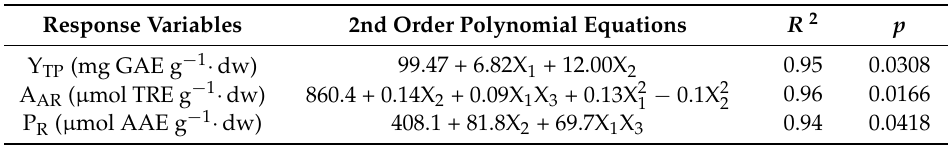
Table 2. Polynomial equations and statistical parameters calculated after implementation of a 2 3 -full factorial, central composite experimental design.